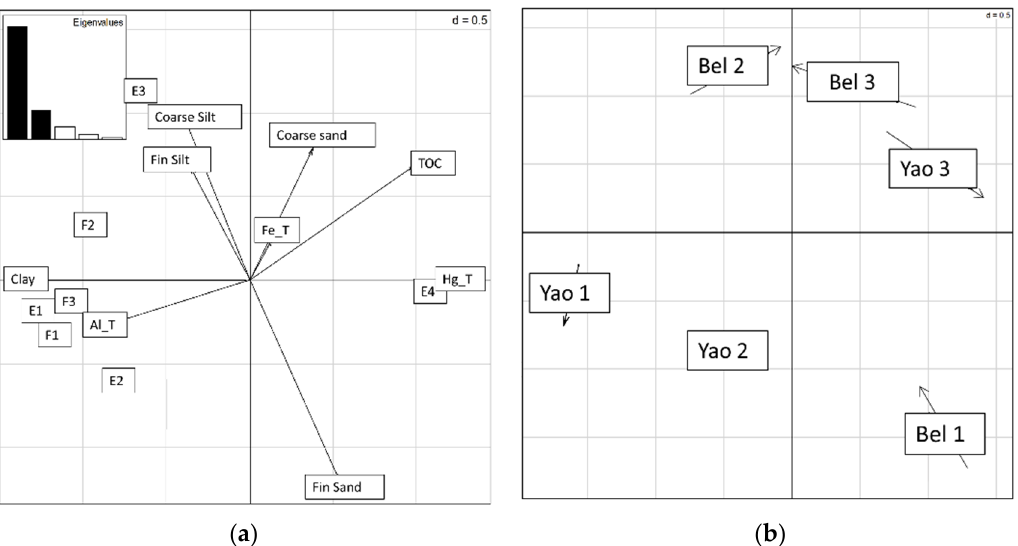
Figure 4. ( a ) Co-inertia analysis between soil physico-chemical parameters and mercury extraction. The variables linked by lines refer to the physico-chemical variables, the other variables refer to the different extractions and fractions of mercury in the samples; ( b ) discriminant analysis on co-inertia variable of soil samples. Circles and boxes represent the projected co-ordinates of physico-chemical dataset and mercury dataset of each rehabilitated site, respectively. The length of the arrow is proportional to the divergence between the data sets. Eigen values 67.96% and 20.34% for axis 1 to 2, respectively. Randtest: simulated p -value: 0.0001. Explained variance: 82.06%.